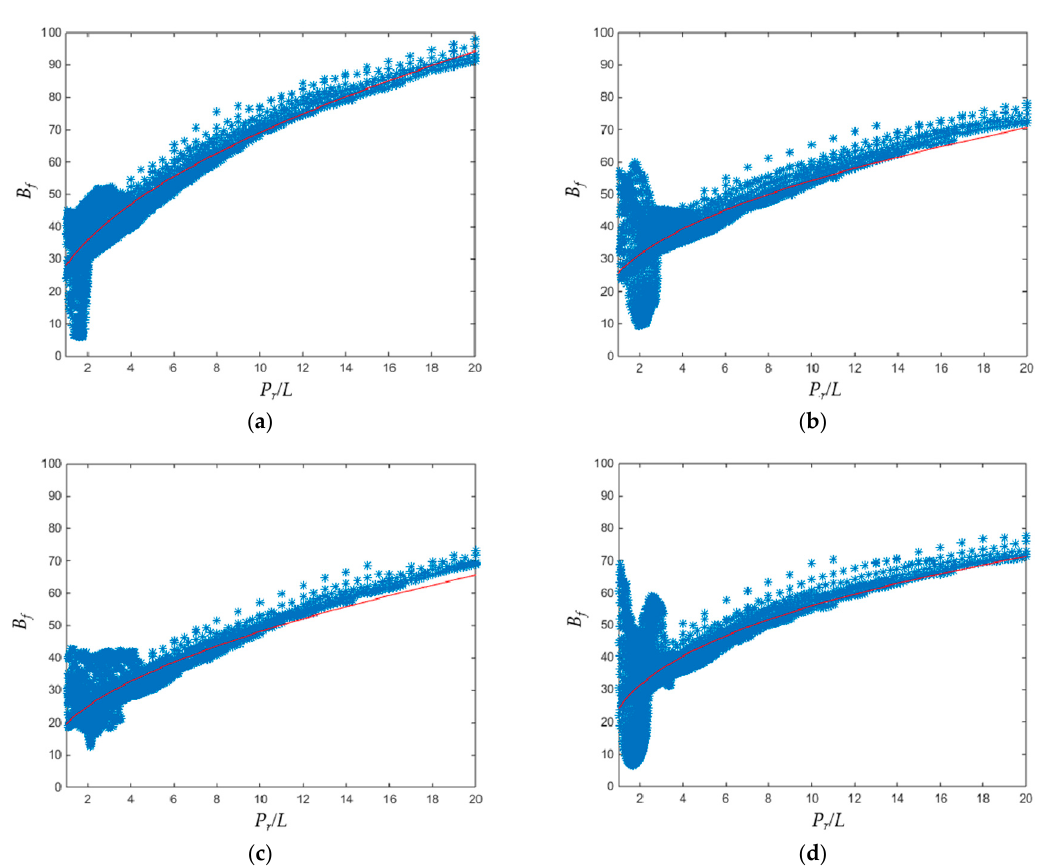
Figure 8. Fit curves of the Bf for four examples: ( a ) position 1, ( b ) position 2, ( c ) position 3, and ( d ) position 4.